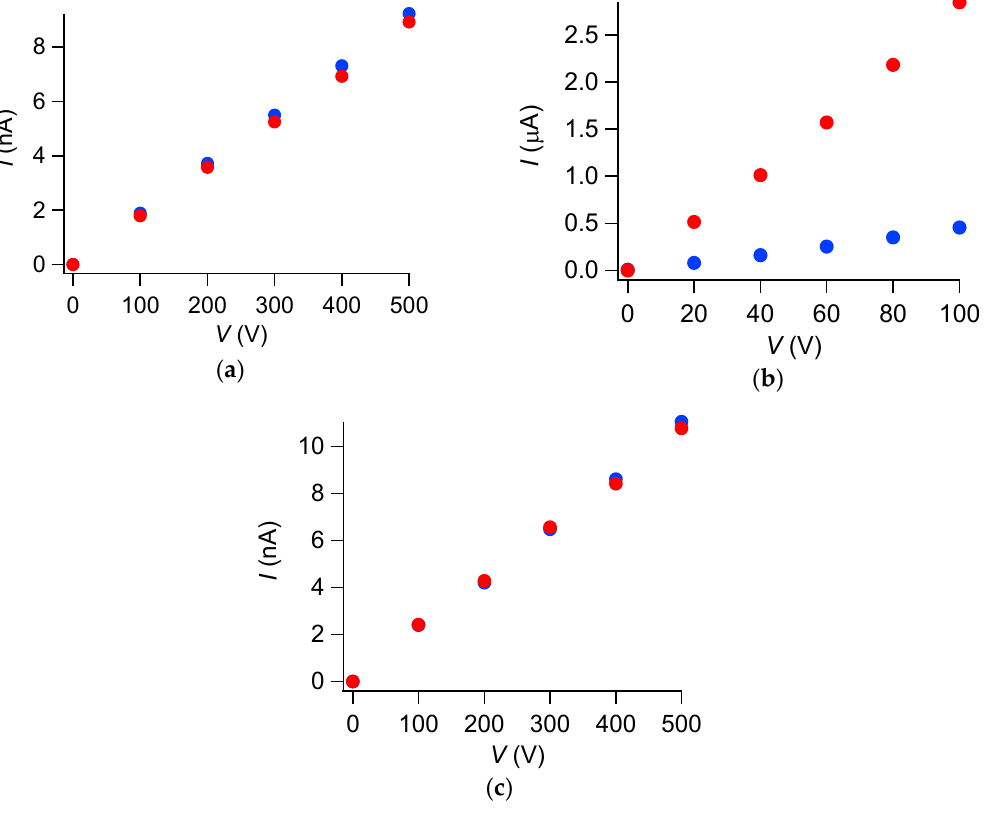
Figure 4. Observed current under dark and UV ‐ irradiated conditions of γ‐ , δ‐ and 2:3 ‐ salts. Red; under UV ‐ irradiation (254–450 nm), blue; under dark condition: ( a ) γ‐ salt; ( b ) δ‐ salt; ( c ) 2:3 ‐ salt.